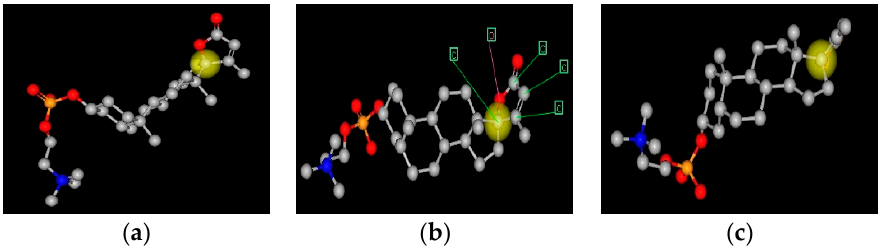
Figure 1. Three representations of a spiral steroid ‐ C341. This figure shows three representations of C341. The yellow ball is on carbon 17, the spiral carbon atom. The view in panel ( a ) is face on to the E ‐ ring and edge on to the B ‐ C ‐ D gonane rings; panel ( c ) is face on to the B ‐ C ‐ D gonane rings and edge on to the E ‐ ring; panel ( b ) is intermediate in orientation. Panel B also has arrows pointing to the five atoms that form the E ‐ ring.